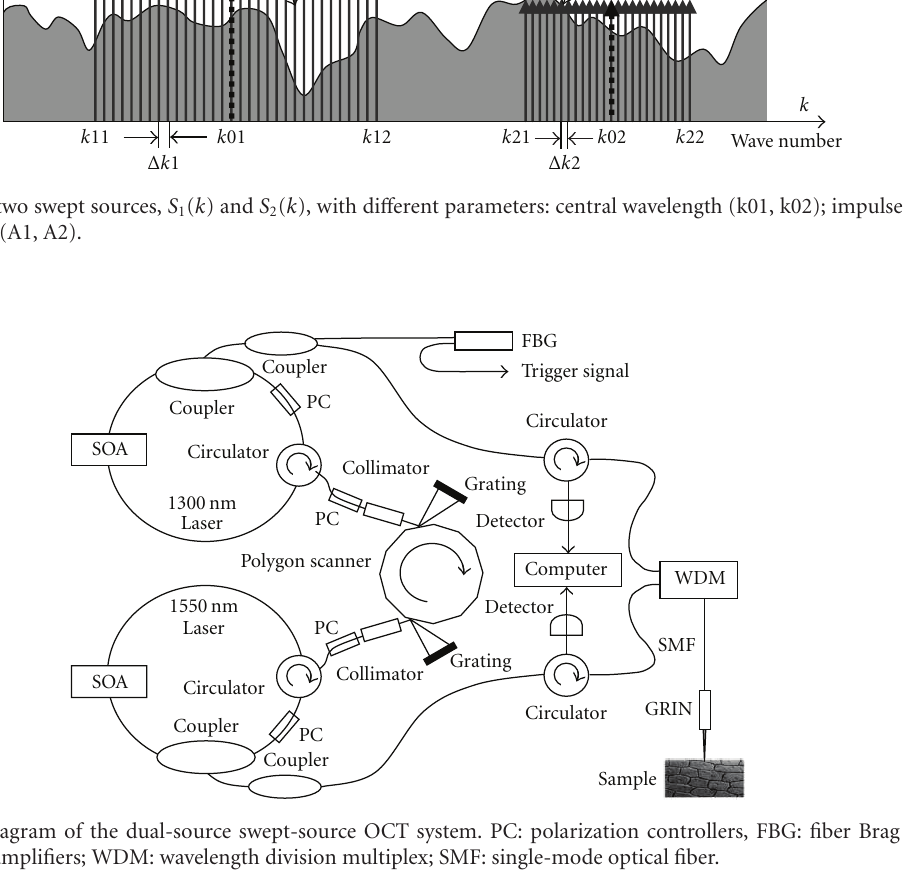
of the light source, the output of OCT system can be ex- pressed